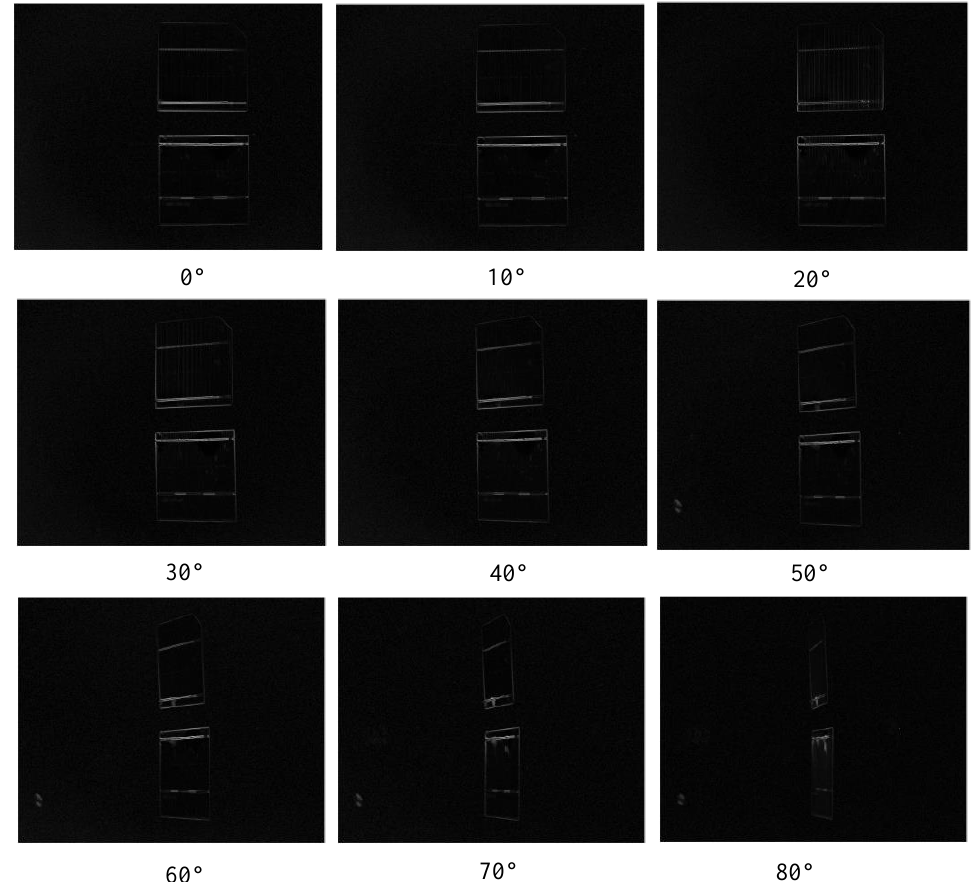
Figure 20. Images DOP of monocrystalline silicon and polycrystalline silicon cells.